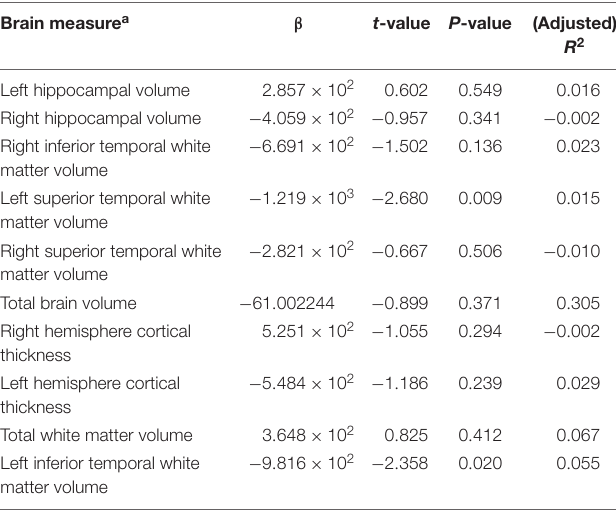
TABLE 2 | Linear regression results for brain structural measures and polygenic risk